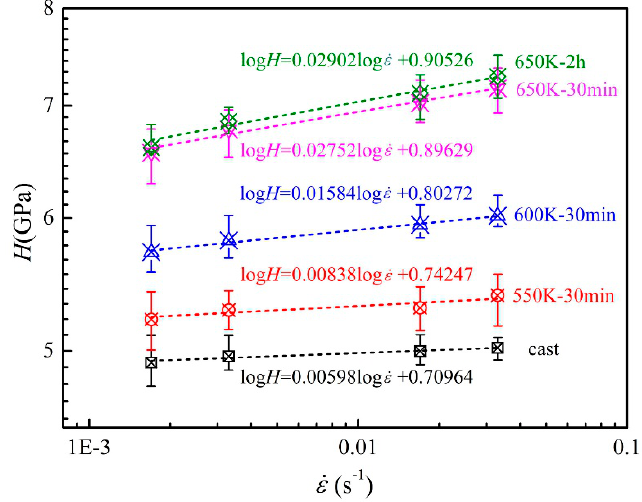
Figure 4. The variation of pop-in lengths with strain rates for various structural states.